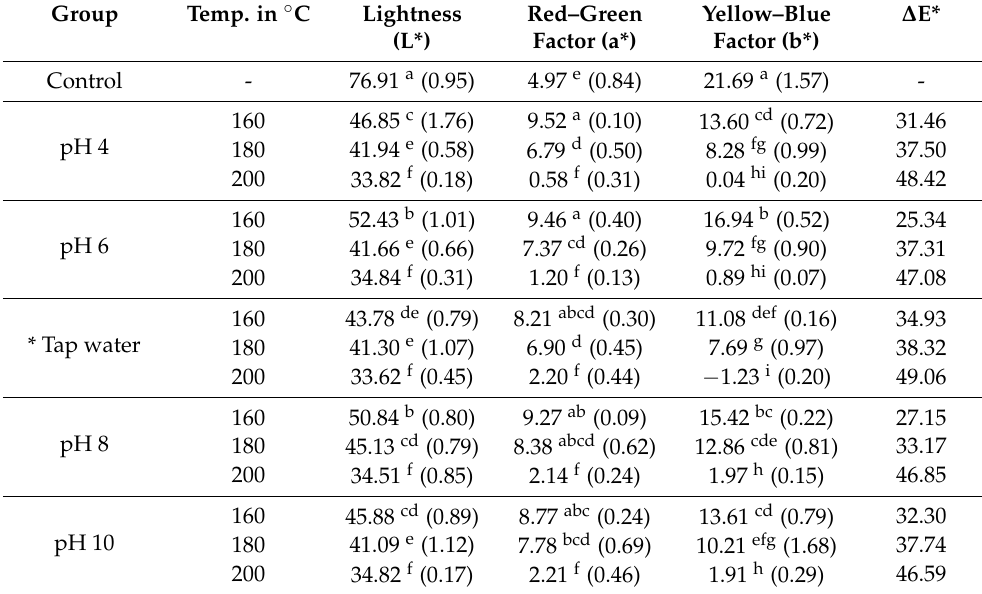
Table 1. Changes in chromatic value of treated and untreated samples of